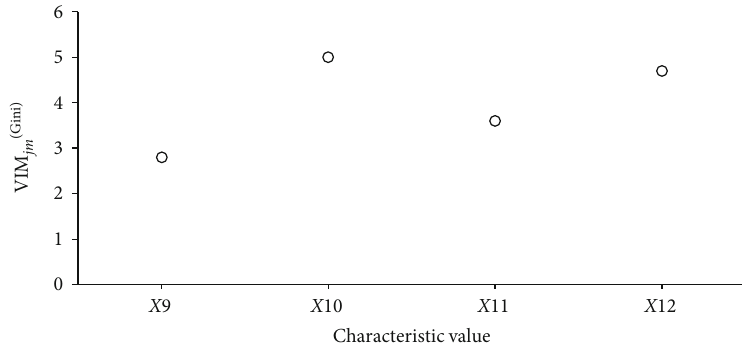
Figure 5: Gini coe ffi cient importance scatter plot of psychological characteristics.